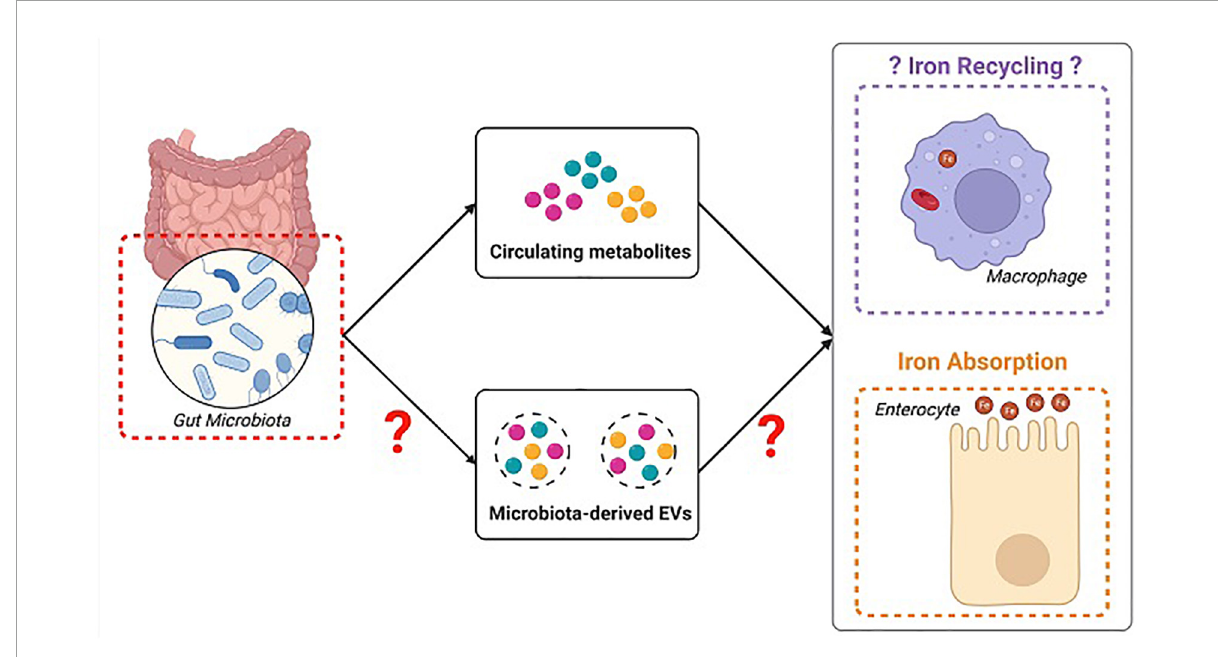
FIGURE3 Schematic representation of the putative role of metabolite carrying microbiota-derived extracellular vesicles (EVs) in modulating iron homeostasis. Gut microbiota metabolites mainly interfere in iron homeostasis by acting on iron absorption at the level of the gut. They may possibly interfere with heme recycling at the level of the macrophages. We propose that those metabolites can be released in EVs. ©Created with